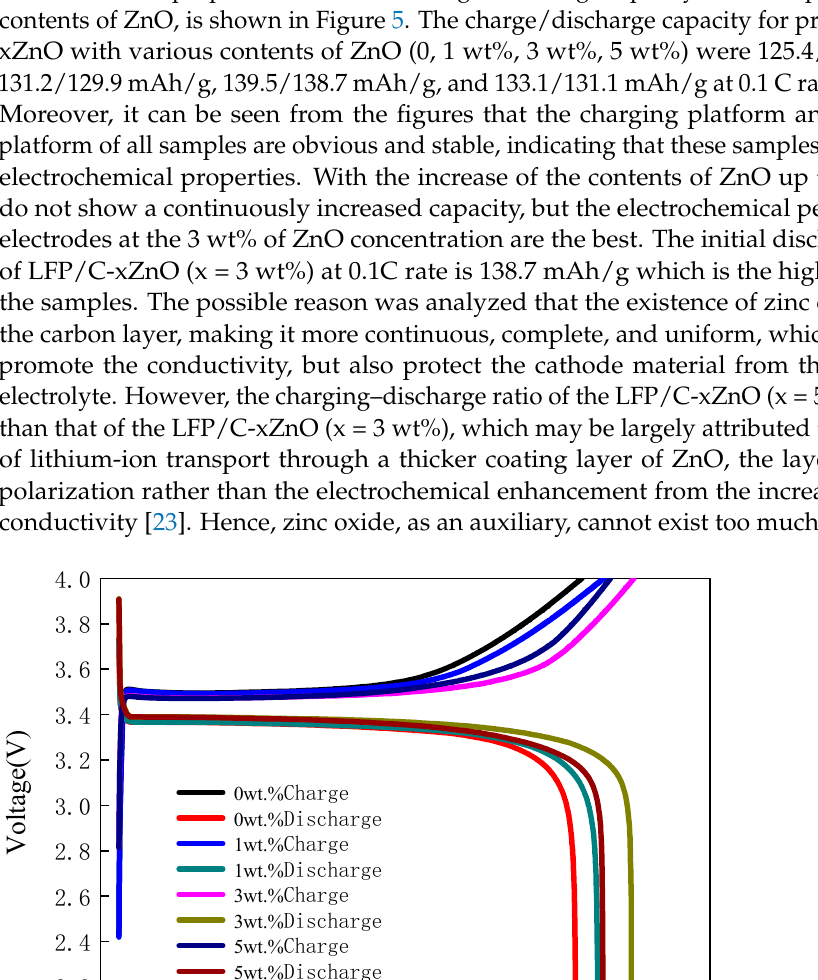
Figure 4. TEM images of LFP/C-xZnO sample of ( a ) bare ZnO doped LiFePO 4 and ( b ) ZnO of 3 wt% doped LiFePO 4 .